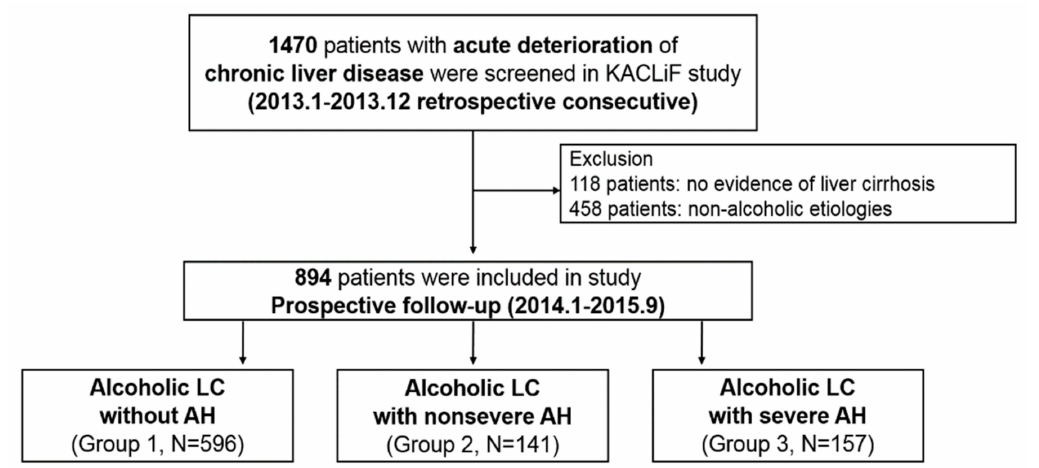
Figure 1. Flowchart of patients enrolled in the study. AH, alcoholic hepatitis; KACLiF, Korean Acute-on-Chronic Liver Failure; LC, liver cirrhosis; N, number. Patients who were lost during follow-up or underwent liver transplantation (LT) were